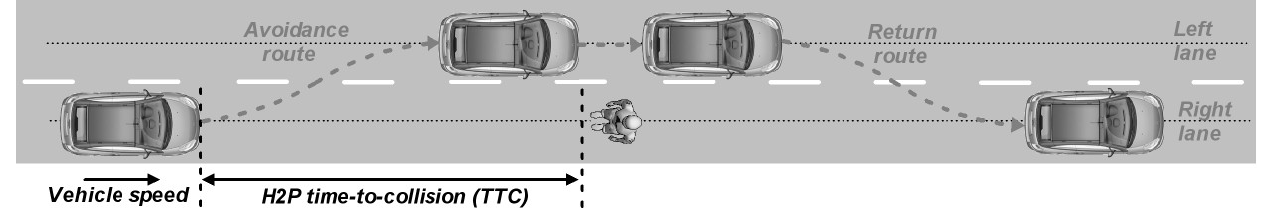
Figure 3. Pedestrian collision avoidance